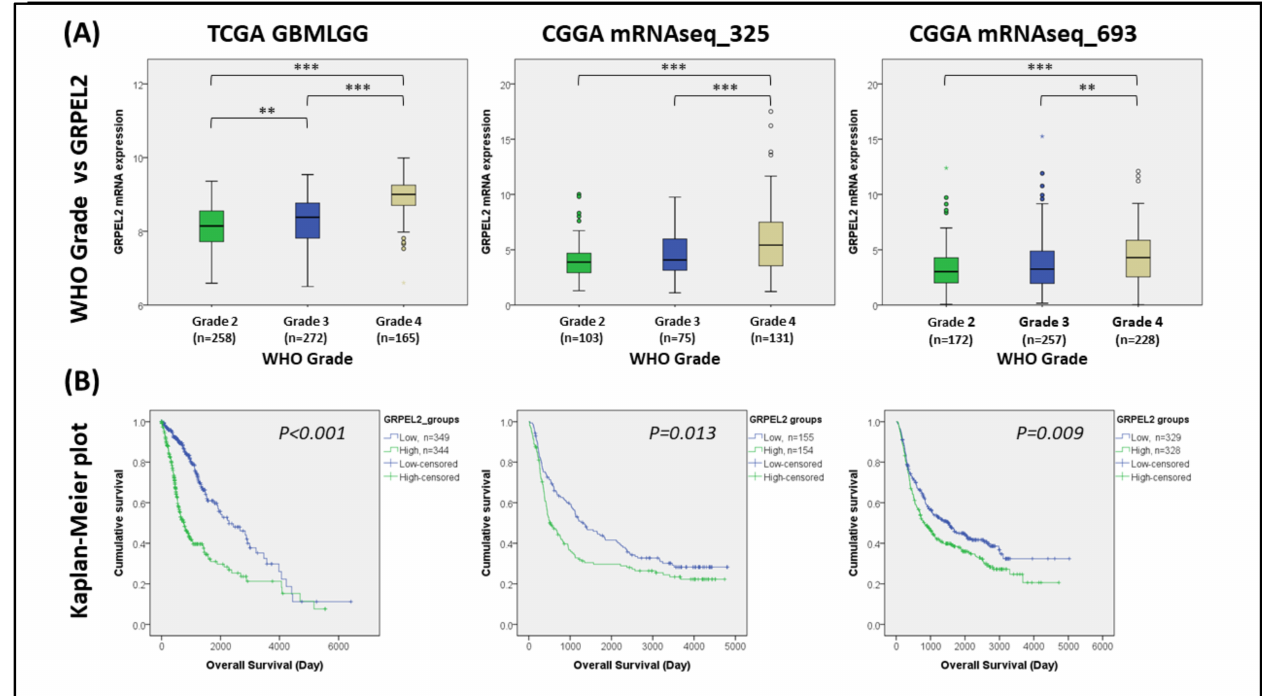
Figure 1. Elevated GRPEL2 expression correlated with higher tumor grade and poorer prognosis in gliomas. ( A ) The boxplots showing GRPEL2 gene expression correlate with the WHO grade of glioma patients in the TCGA and CGGA databases. ** p < 0.01, *** p < 0.001 ( B ) Kaplan–Meier graphs of GRPEL2 mRNA expression level (high-expression versus low-expression groups) compared the survival probability from the TCGA and CGGA datasets. The plotted Kaplan–Meier curvatures used the log-rank test and the one-way ANOVA used for evaluating grade versus GRPEL2 ( p < 0.001 for TCGA data; p = 0.013 for CGGA mRNAseq_325 and p = 0.009 for CGGA mRNAseq_693 datasets,